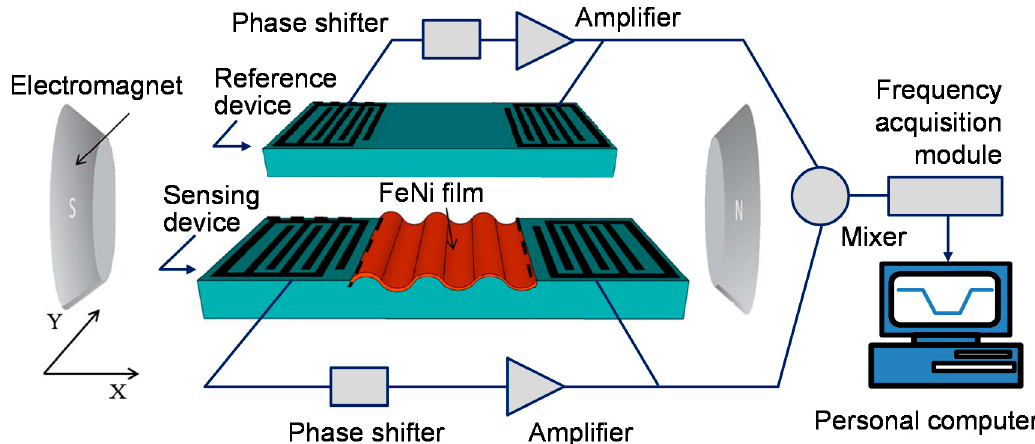
Figure 1. The scheme and working principle of the surface acoustic wave (SAW) current sensor.